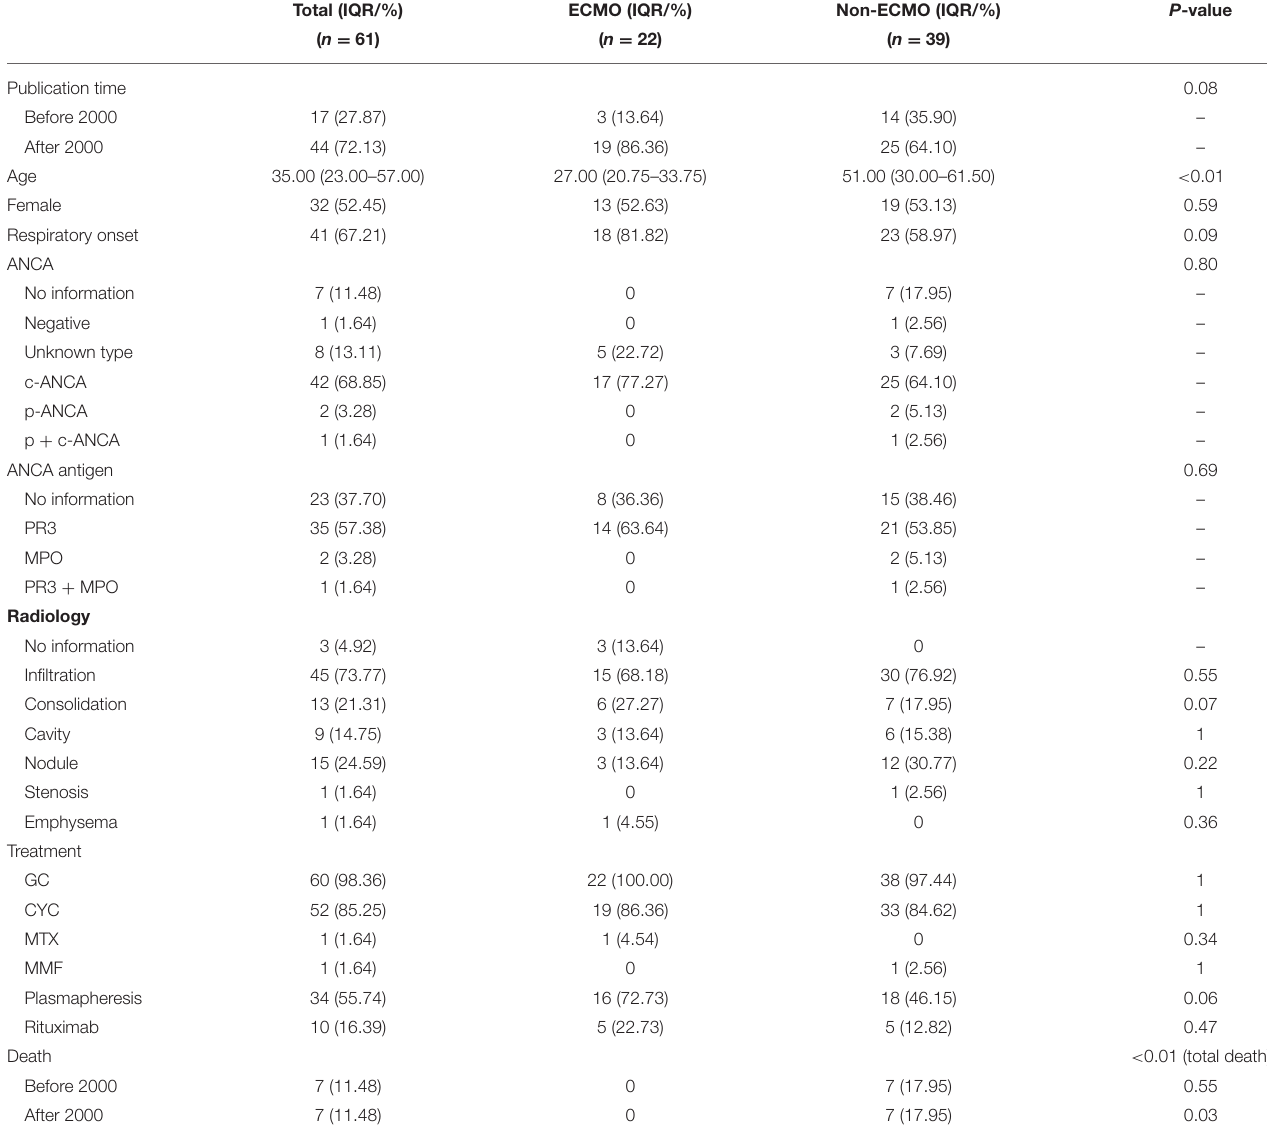
TABLE 3 | Summary of cases of respiratory failure due to